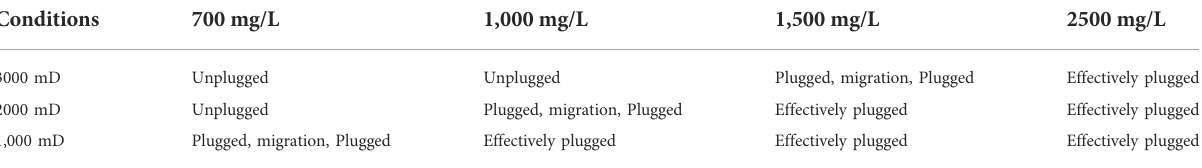
TABLE 8 Matching relationship between polymer gel system and reservoir under different schemes.